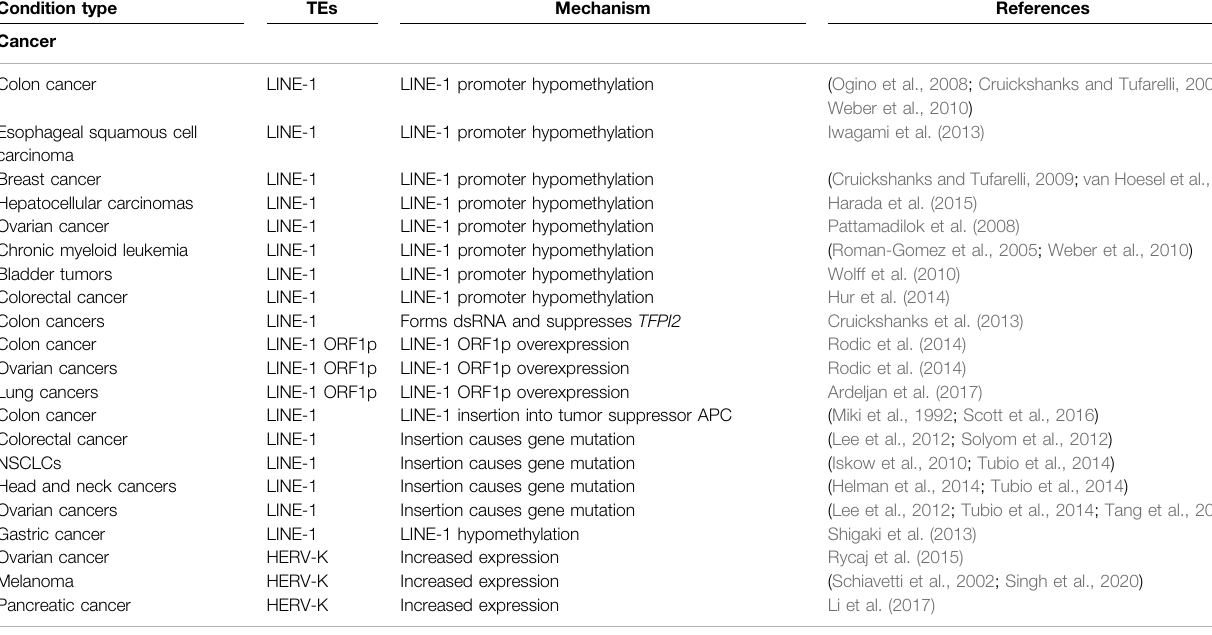
TABLE 1 | Transposable elements implicated in human